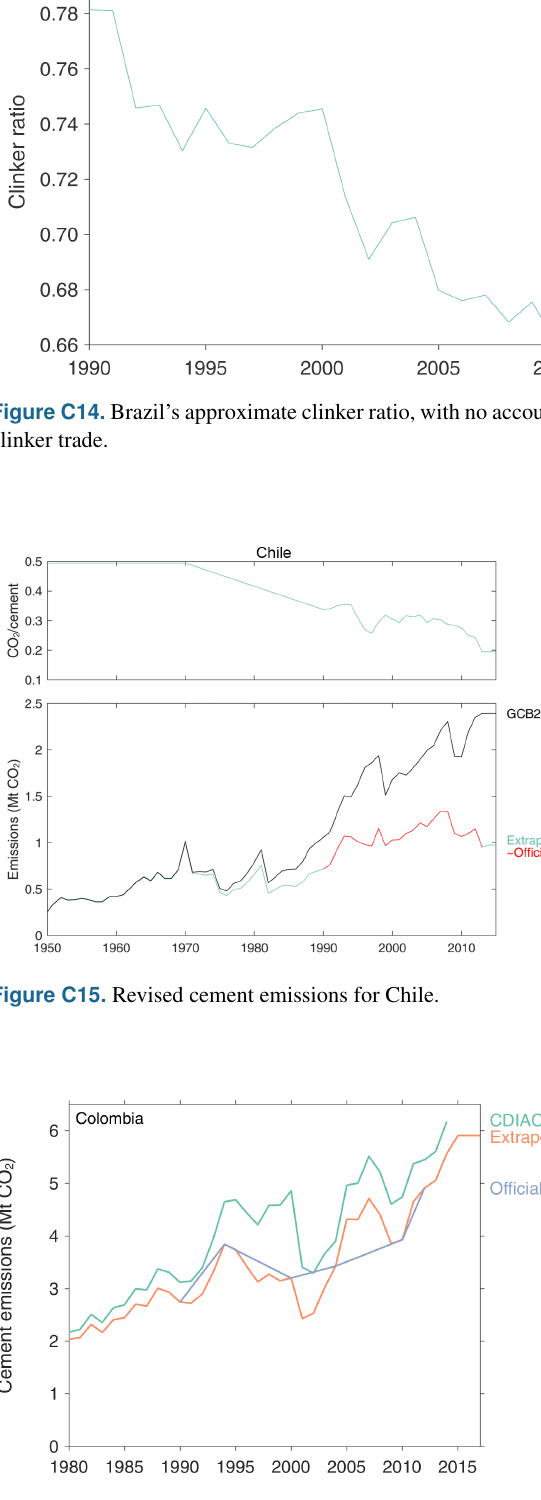
Figure C16. Revised cement emissions in